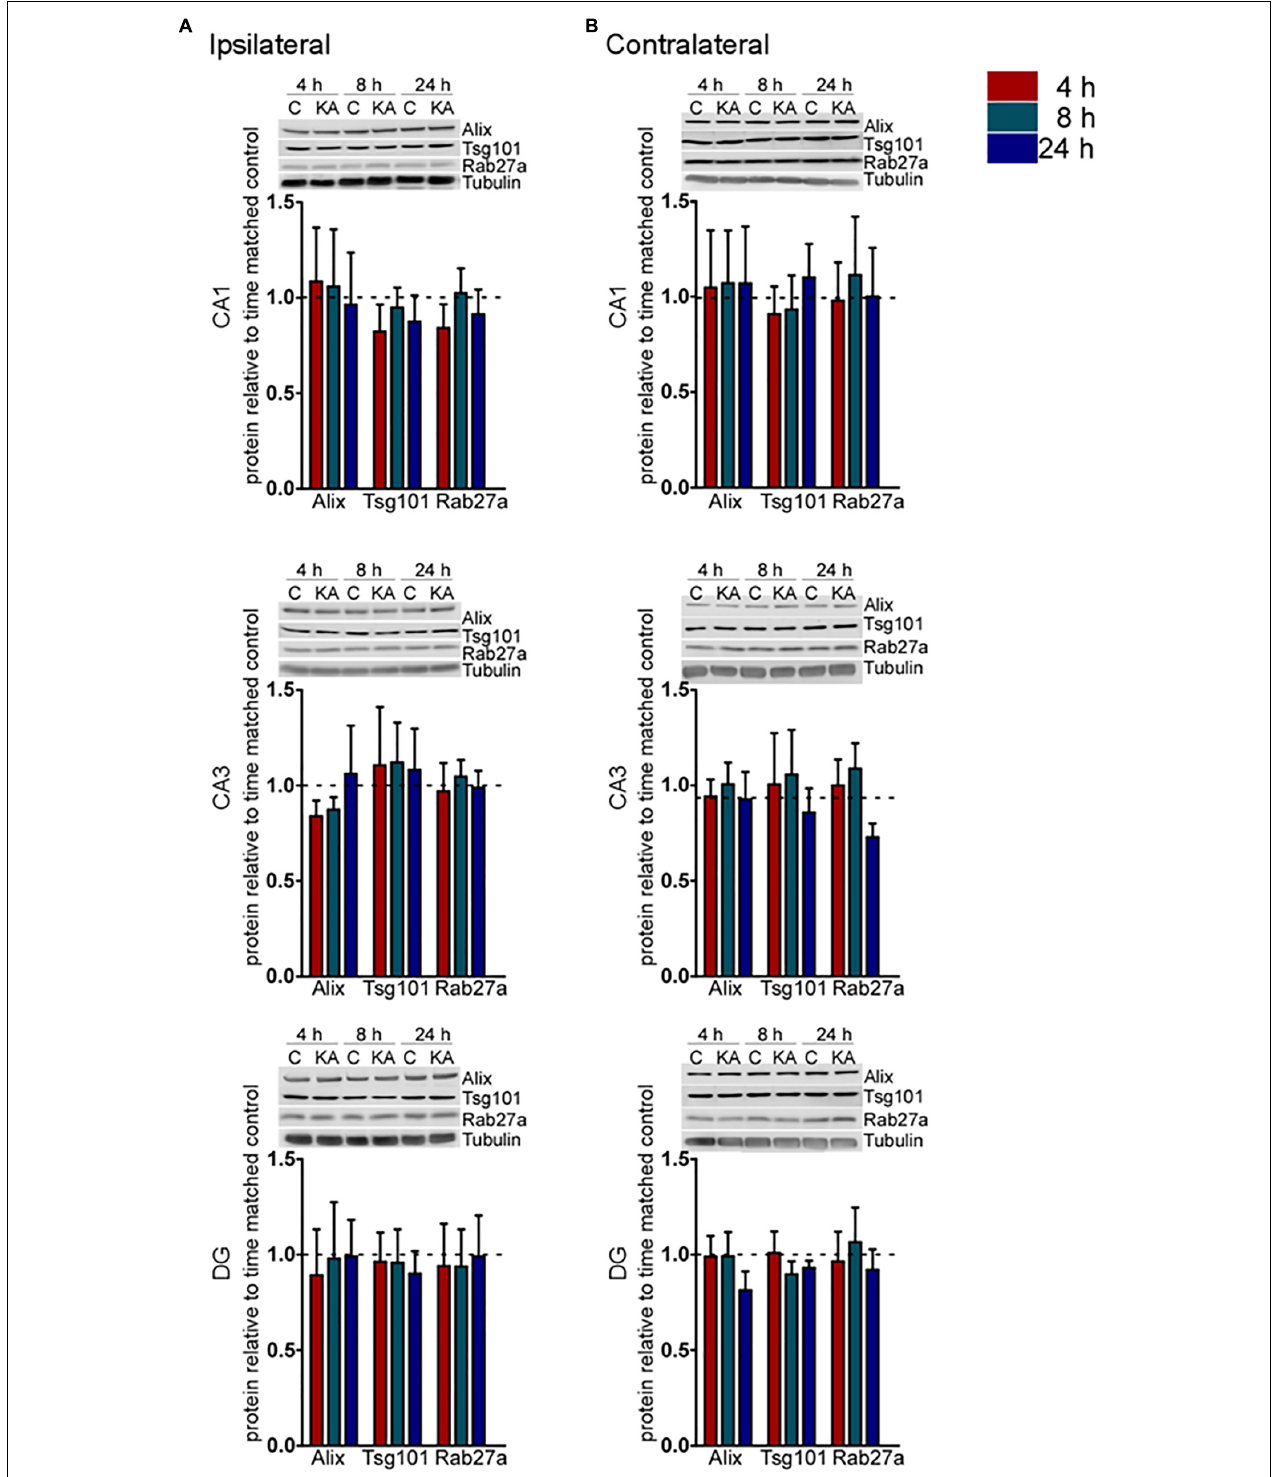
FIGURE 2 | Acute regulation of protein levels of exosome biogenesis pathways after status epilepticus in hippocampal subfields. Representative immunoblots and graphs show protein levels of Alix, Tsg101, and Rab27a exosome pathway components 4, 8, and 24 h after SE compared to control (C) in each subfield of the (A) ipsilateral and (B) contralateral, hippocampus. Graphs show mean ± SEM. Protein levels were normalized to tubulin ( n = 4–5 per group; ANOVA with Bonferroni post hoc test showed no significant differences).